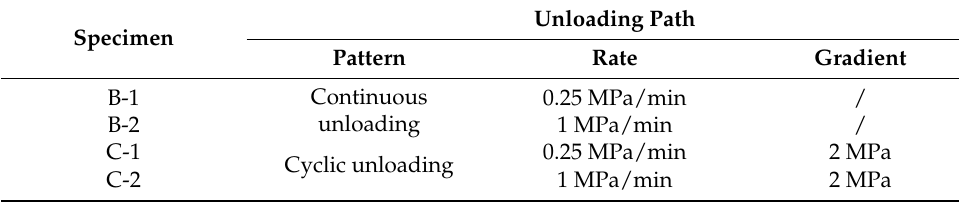
Table 2. Test procedure and schemes.